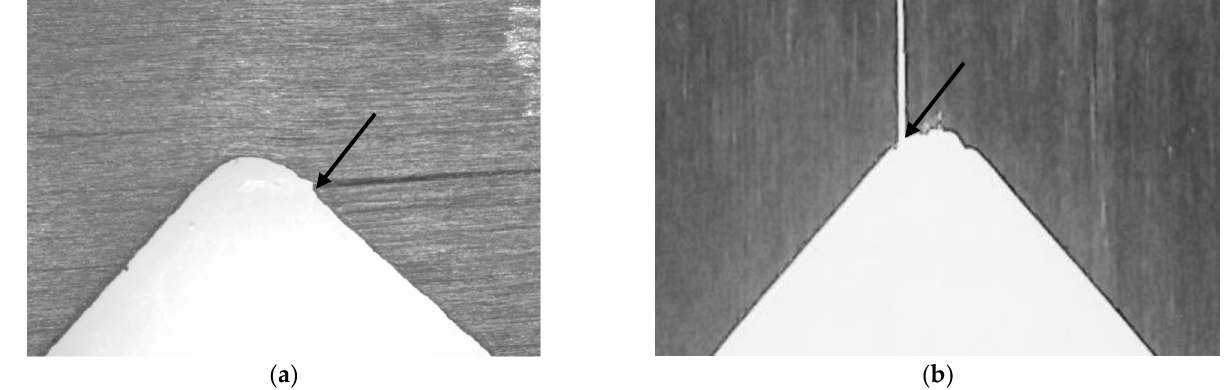
Figure 9. Sites of delamination cracks in DVN coupons for various orientations; ( a ) 0°; ( b ) 90°.